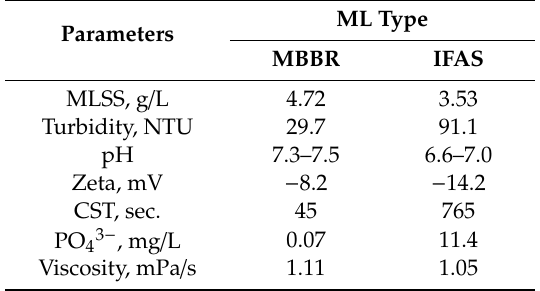
Table 1. Characteristics of Mixed Liquors (MLs) sampled from MBBR and IFAS treatment plants.